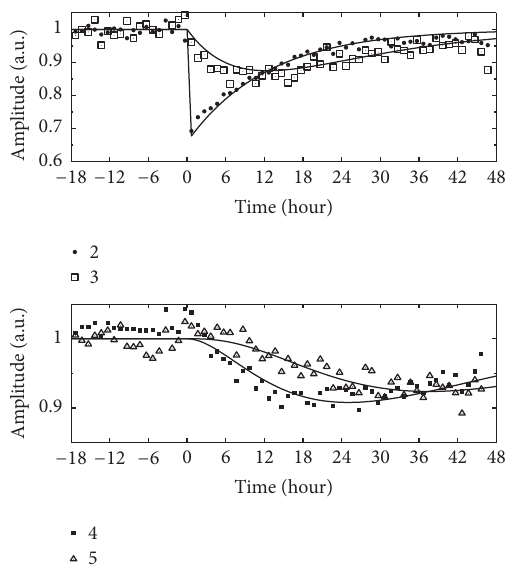
Figure 13: Mean signal amplitude for detector layers 2, 3, 4, and 5, relative to the first layer, after injection of ambient air to the gas flow, corresponding to 13000 ppm air contamination. The air was inserted from a bypass at 𝑡 = 0 into the second detector layer and flows along the gas line to the subsequent chambers. Predictions for the detectors, assuming full gas mixing (see the text for explanation), are indicated by the